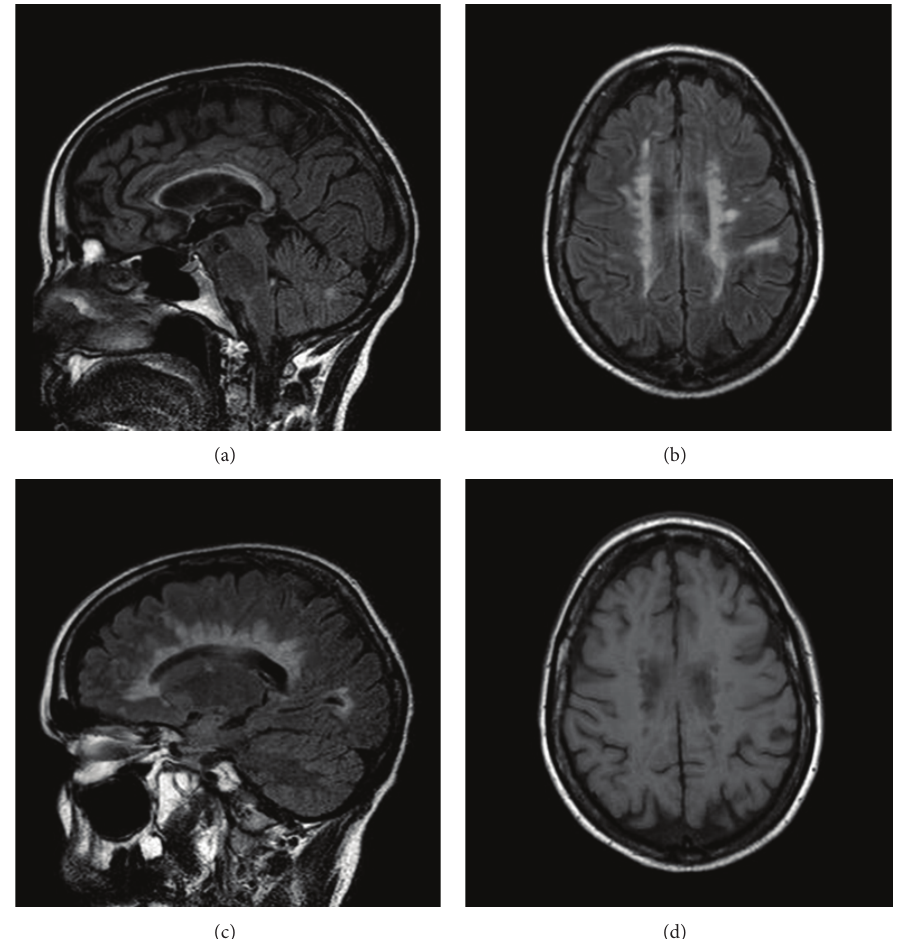
Figure 2: Sagittal (a), axial (b), and parasagittal (c) FLAIR MRI scan showing corpus callosum involvement. T1 axial scan (d) showing the presence of numerous T1 hypointense lesions (“black